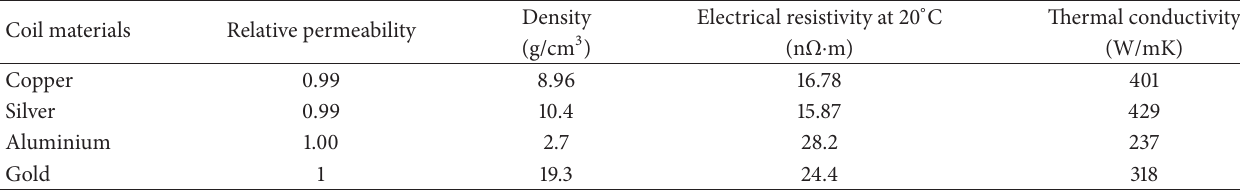
Figure 7: Schematic diagram of reported EM-VEHs: (a) membrane type EM-VEH, (b) cantilever beam type EM-VEH, (c) top view of beam type EM-VEH, (d) cross-sectional view of beam type EM-VEH, and (e) moving coil type EM-VEH. Table 4: Planar coil materials and their